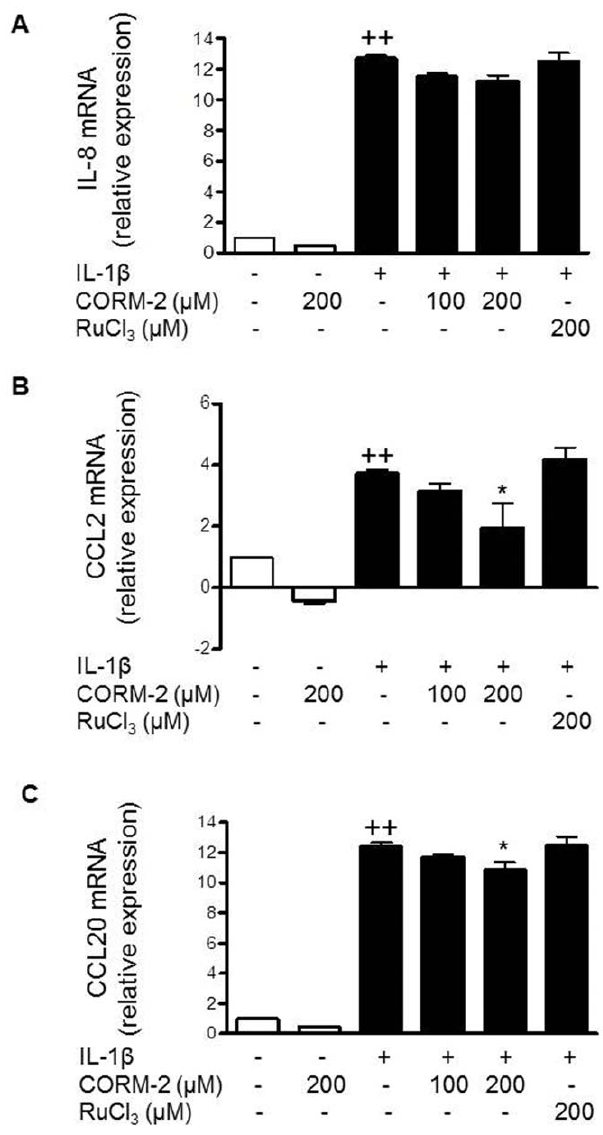
Figure 4. Effect of CORM-2 on chemokine mRNA levels in OA synoviocytes. (A) IL-8, (B) CCL2 and (C) CCL20 mRNA levels. Cells were stimulated with IL-1 b (10 ng/ml) for 16 h in the presence or absence of CORM-2 (100, 200 m M) or RuCl 3 (200 m M). mRNA expression was determined by real-time PCR. Data are expressed as mean 6 S.E.M. Duplicate samples from 3 patients were used. ++ P , 0.01 with respect to nonstimulated cells. * P , 0.05, ** P , 0.01 with respect to IL-1 b .